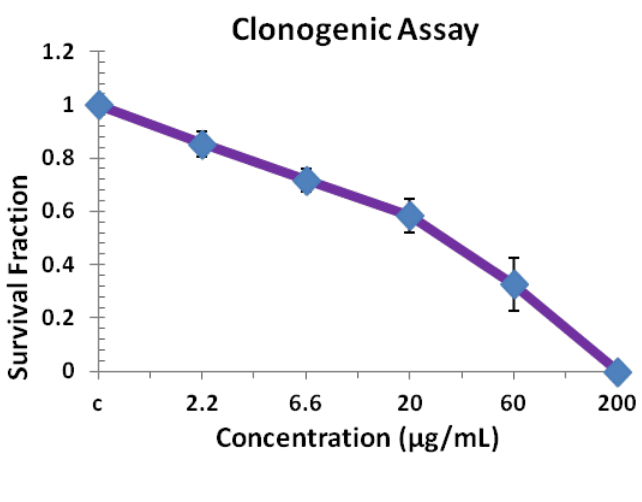
Figure 5. Effect of compound 2 on colony forming capacity and survival of exponentially growing T98G cell lines studied by macro colony assay. Data presented are mean values from three independent observations, n =